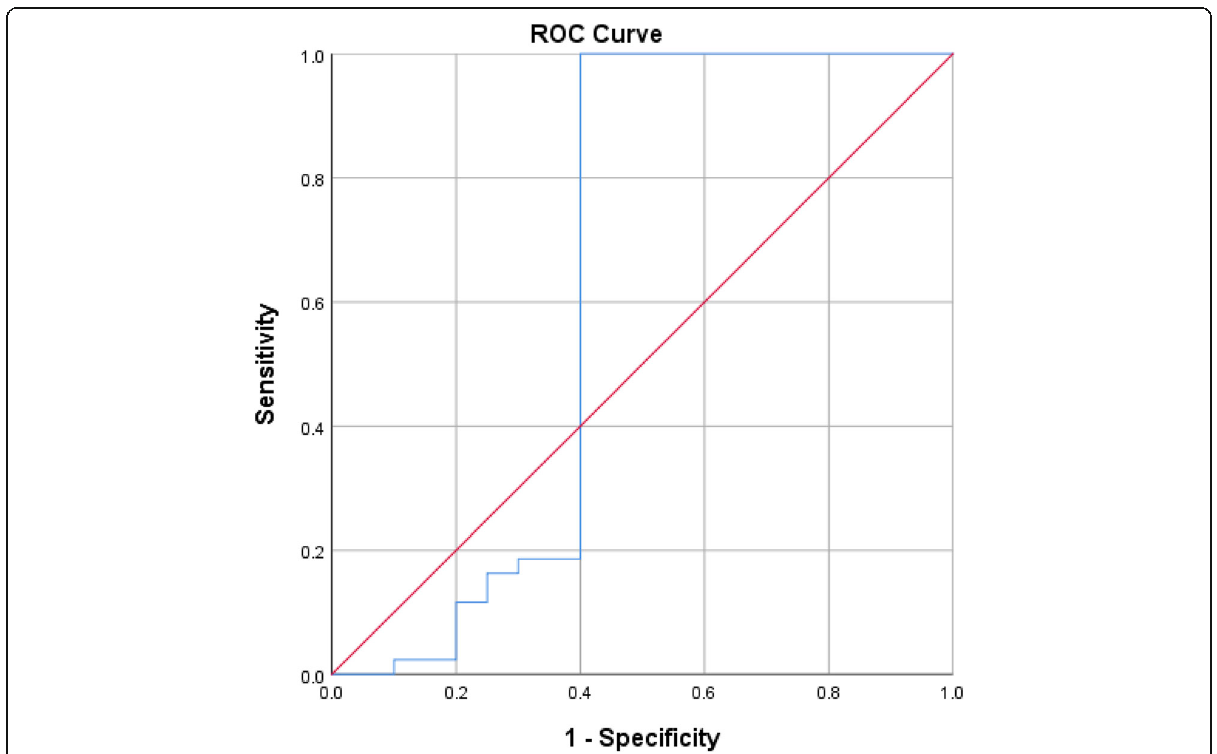
Fig. 4 ROC curve for signal intensity index in differentiation between clear cell RCC and non-clear cell